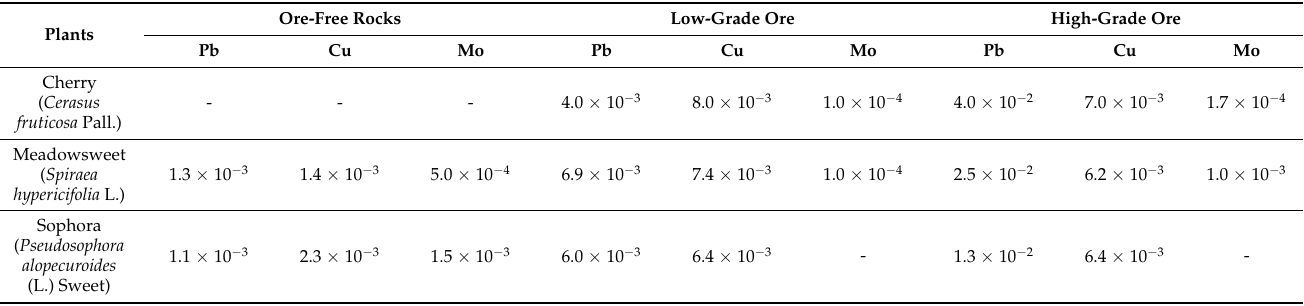
Table 3. Metal content (%) in the ash of plants growing over rocks with varying Pb, Zn, and Cu levels in the Karatau Mountains. Ore-Free Rocks Low-Grade Ore High-Grade Ore Plants